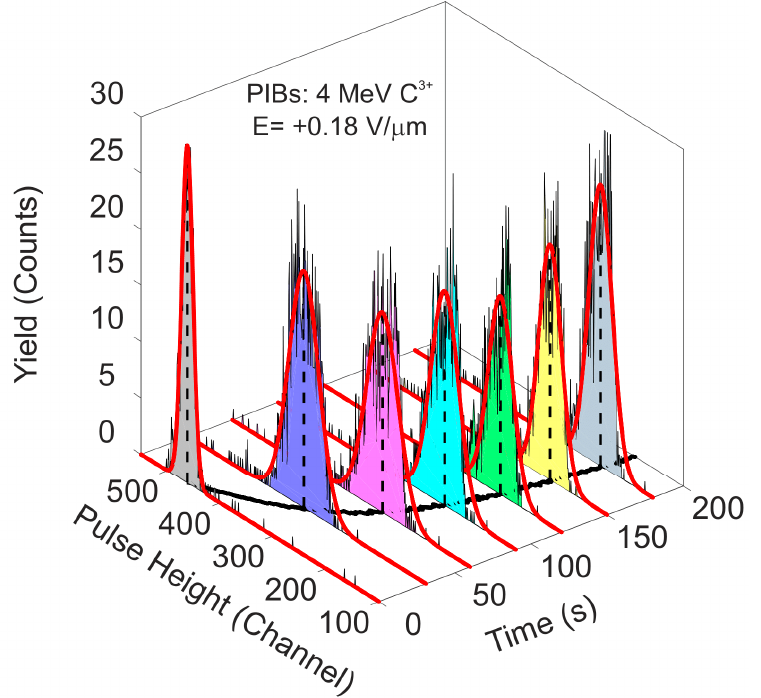
Figure 4. Train of histograms at different times from the beginning of the irradiation obtained with IBIC using a 4 MeV C 3+ microbeam.